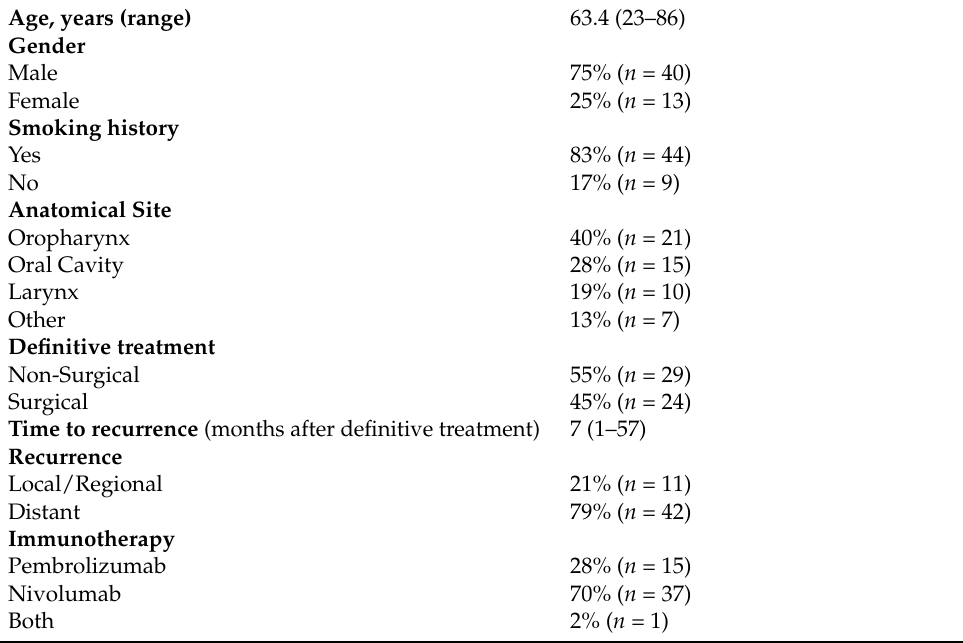
Table 1. Clinicopathologic characteristics of R/M HNSCC patients treated with anti-PD-1